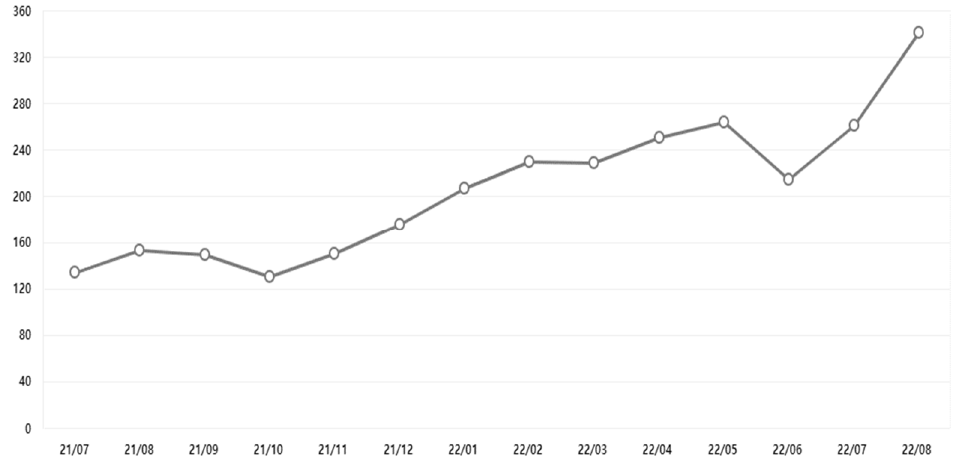
Figure 9. The trend of the weighted average of SMP on Jeju Island for a recent year * [17]. * x -axis: Year/Month, y -axis: SMP Average (KRW/kWh).